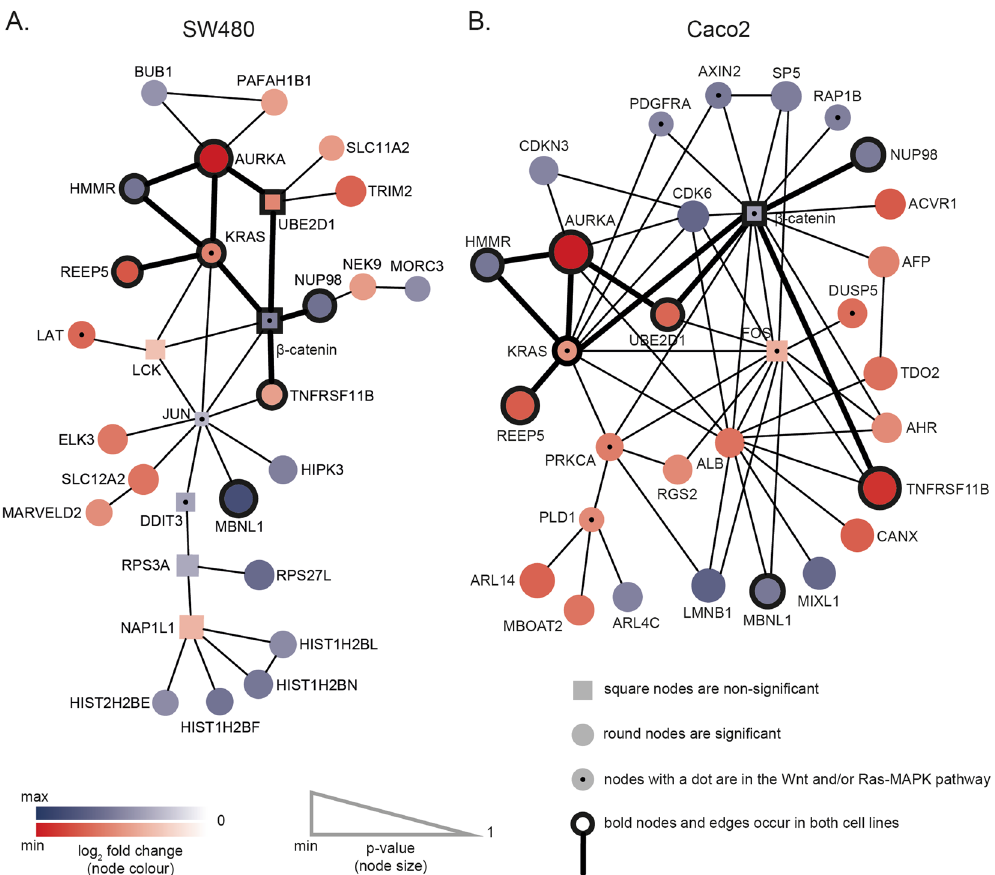
Figure 2. Significantly deregulated gene modules in SW480 ( A ) and Caco2 ( B ) derived from integrating p-values from differential mRNA expression analysis (DEA) upon downmodulation of AURKA and STRING protein-protein interaction network data using the Heinz algorithm. ( A ) and ( B ) Based on the chosen FDR threshold of 6.21e-4 for SW480 and 2.40e-4 for Caco2 in the Heinz analysis, round nodes are significant (p-value lower than the FDR threshold), and squared nodes are non-significant (p-value above the FDR threshold). The size of the nodes is based on the p-values from the DEA: a lower p-value corresponds to a bigger node. The colour of the nodes indicates the direction of the fold change with respect to AURKA downmodulation in the DEA. Red nodes are downregulated and blue nodes upregulated. The colour intensity of the nodes is correlated with the magnitude of the fold change, where the greatest intensities represent the highest absolute fold change. The nodes of the nine genes occurring in both modules are outlined in black and the direct edges between these are in bold. The nodes representing proteins in the Wnt or Ras-MAPK pathways have a black